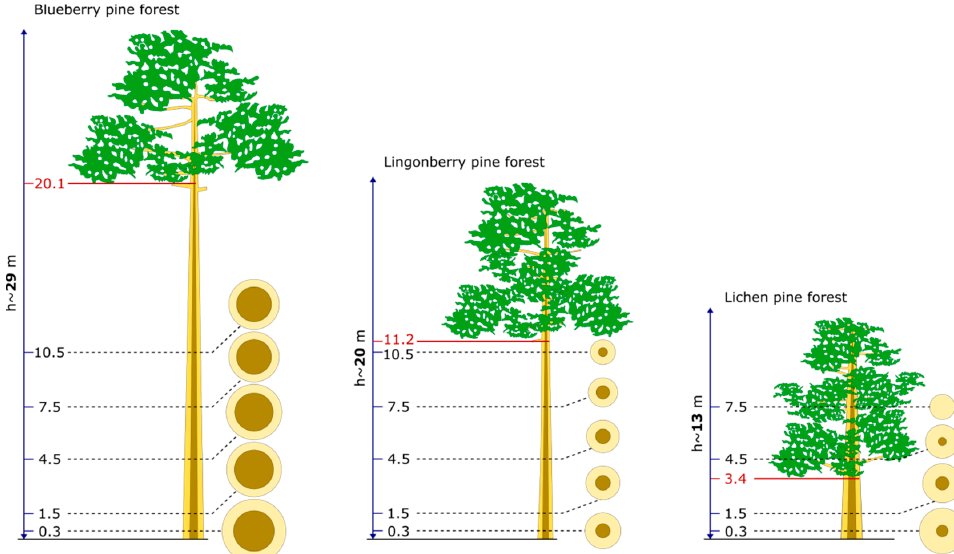
Figure 6. Scheme showing SW proportion (light brown) and HW proportion (dark brown) along the trunk axis in Pinus sylvestris L. trees from blueberry, lingonberry and lichen pine forests. The scheme for the lingonberry pine forest is based on the data provided in the article [45]. For each forest type, the average tree height (h) is given, and a red line indicates the height of the lower crown border. The radius of the trunk cross-sections at a given height and heartwood radius is proportional to the R(W) and the R(HW), respectively.